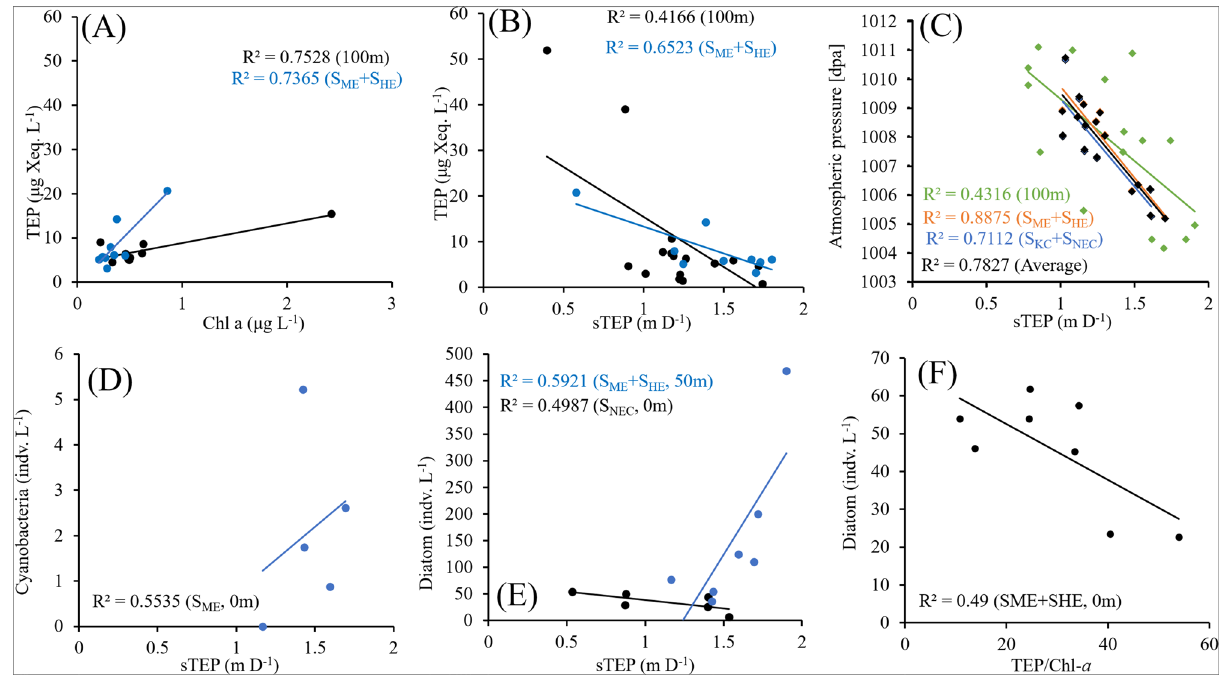
Figure 8. Significant linear regressions of diatoms, cyanobacteria, TEP, TEP/Chl-a ratio and